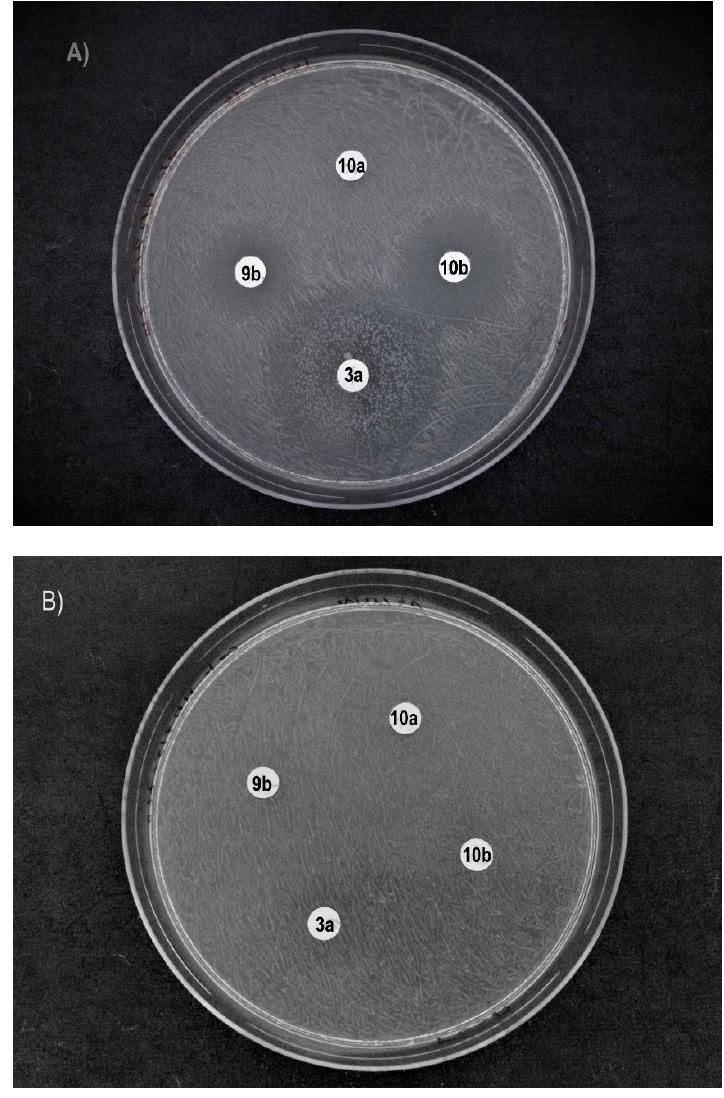
Figure 1. Antimicrobial activity of hydroxamic acids ( 9b , 2 nM), ( 10a , 3 nM) and ( 10b , 1.5 nM) compared to fosmidomycin ( 3a , 2 nM): ( A ) against E. coli XL1 Blue; ( B ) against fosmidomycin-resistant strain E. coli FosR.